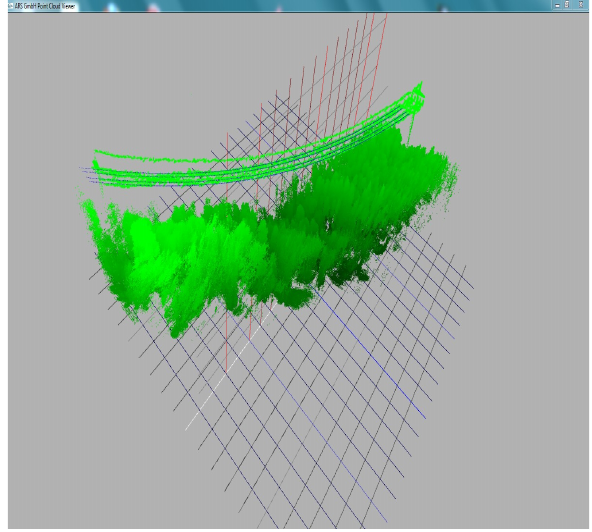
Figure 6. Geo-referenced data of a measurement with sensor package with LD-MRS (data courteously by Cenalo GmbH) The vegetation can be seen clearly. In a zoom perspective single trees are distinguishable and may be identified in the photos. The conductor-ropes are completely covered with measurement points now. Also the grounding-rope at the top is detected. The precision of the scan allows to see the isolators of the pylons and partially even the pylons structure. The distance between ropes and vegetation is measured reliably and used to identify critical trees (not shown in the